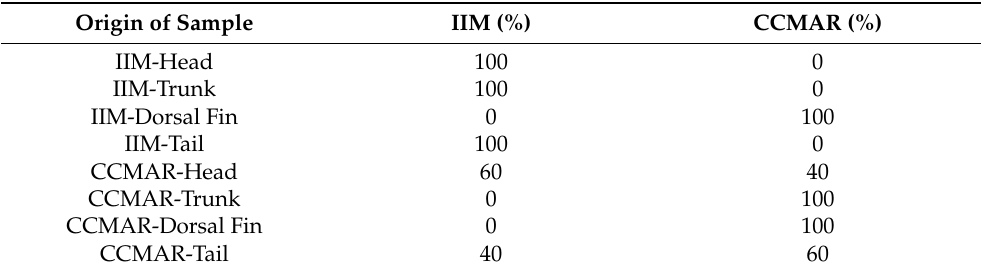
Table 3. Classification success by origin of sample (IIM or CCMAR) of a random forest analysis based on the elemental fingerprints of the four body parts (head, trunk, dorsal fin, and tail) of long-snouted seahorses ( Hippocampus guttulatus ) from Instituto de Investigaciones Marinas (IIM) (Galicia, Spain) and Centro de Ci ê ncias do Mar (CCMAR) (Algarve, Portugal) ( n = 5). Origin of Sample IIM (%) CCMAR (%) IIM-Head 100 0 IIM-Trunk 100 0 IIM-Dorsal Fin 0 100 100 0